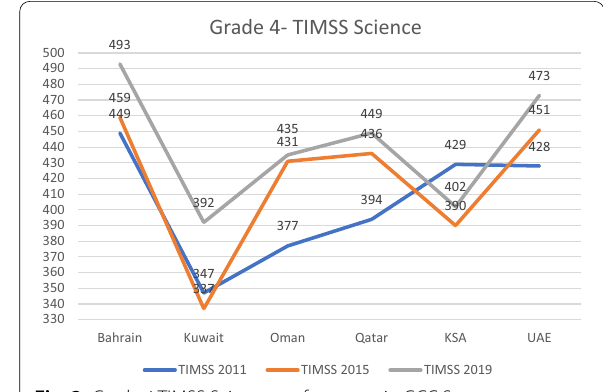
Fig. 2 Grade 4 TIMSS Science performance in GCC States